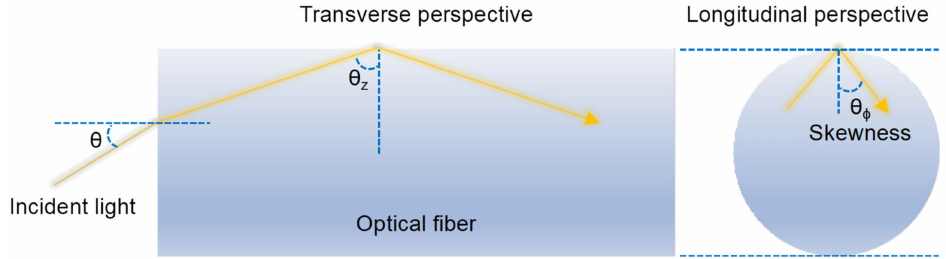
Figure 2. Comparison of di ff erent excitation methods. Inset: propagation behavior for di ff erent ray